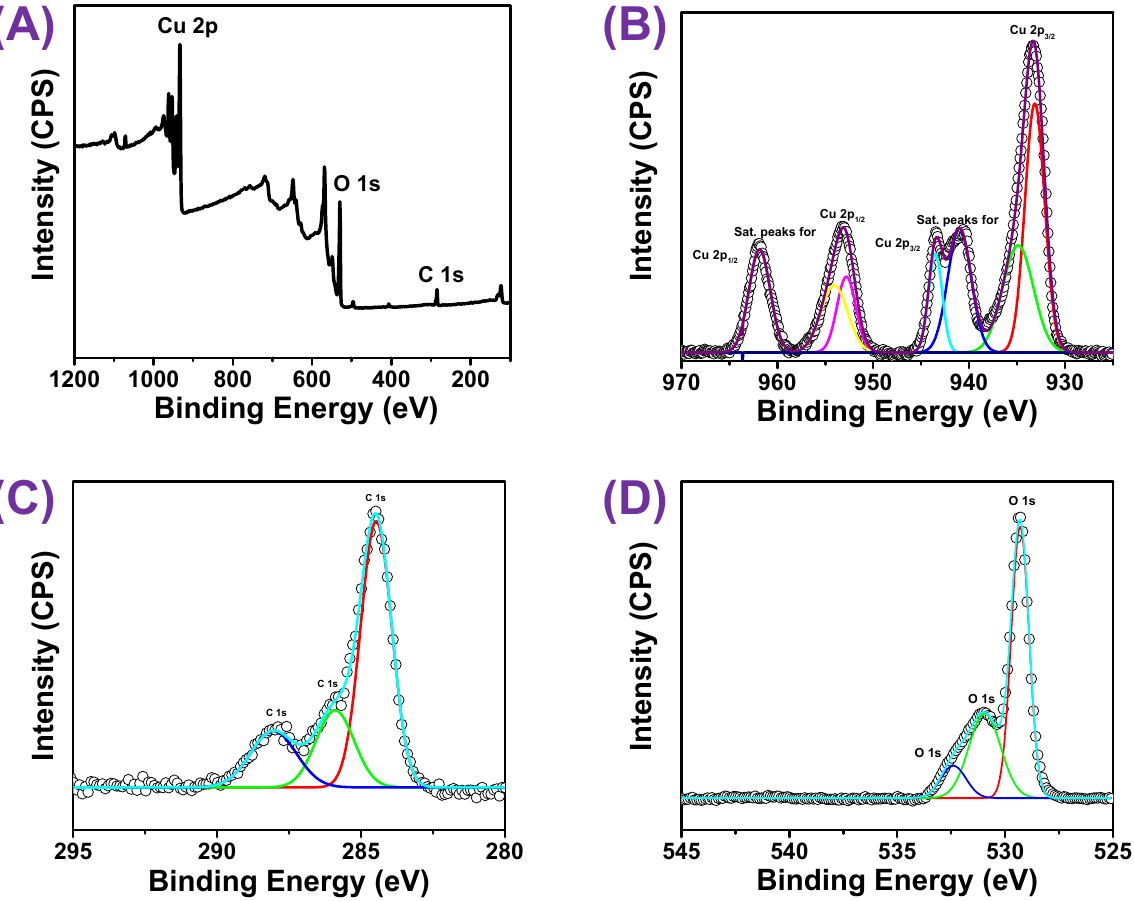
Figure 7. XPS of ( A ) survey scan spectrum, ( B ) Cu 2p, ( C ) C 1s, and ( D ) O 1s.